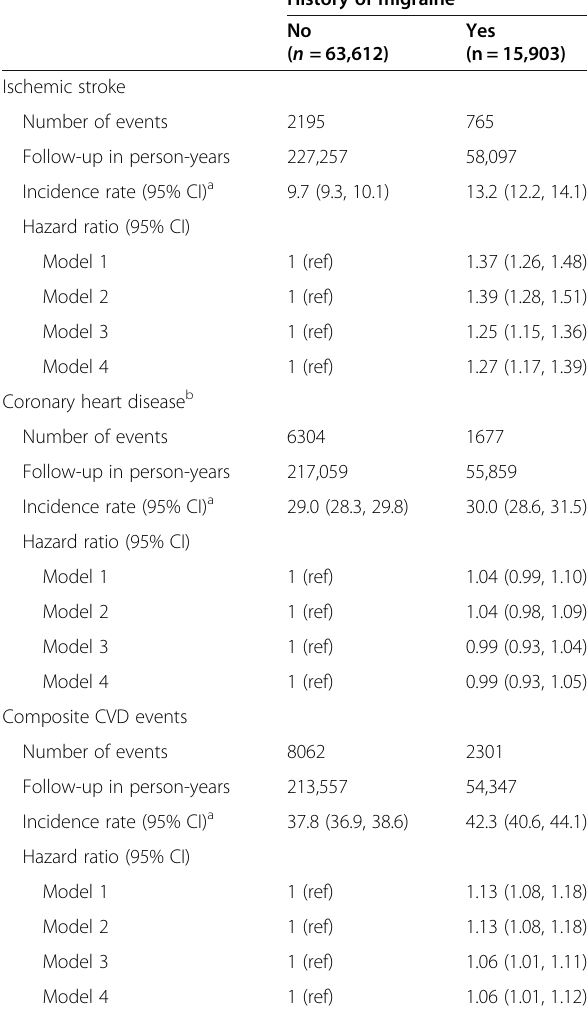
Table 4 Incidence rates and hazard ratios for ischemic stroke, coronary heart disease and cardiovascular disease events associated with a history of migraine among patients with a history of cardiovascular disease